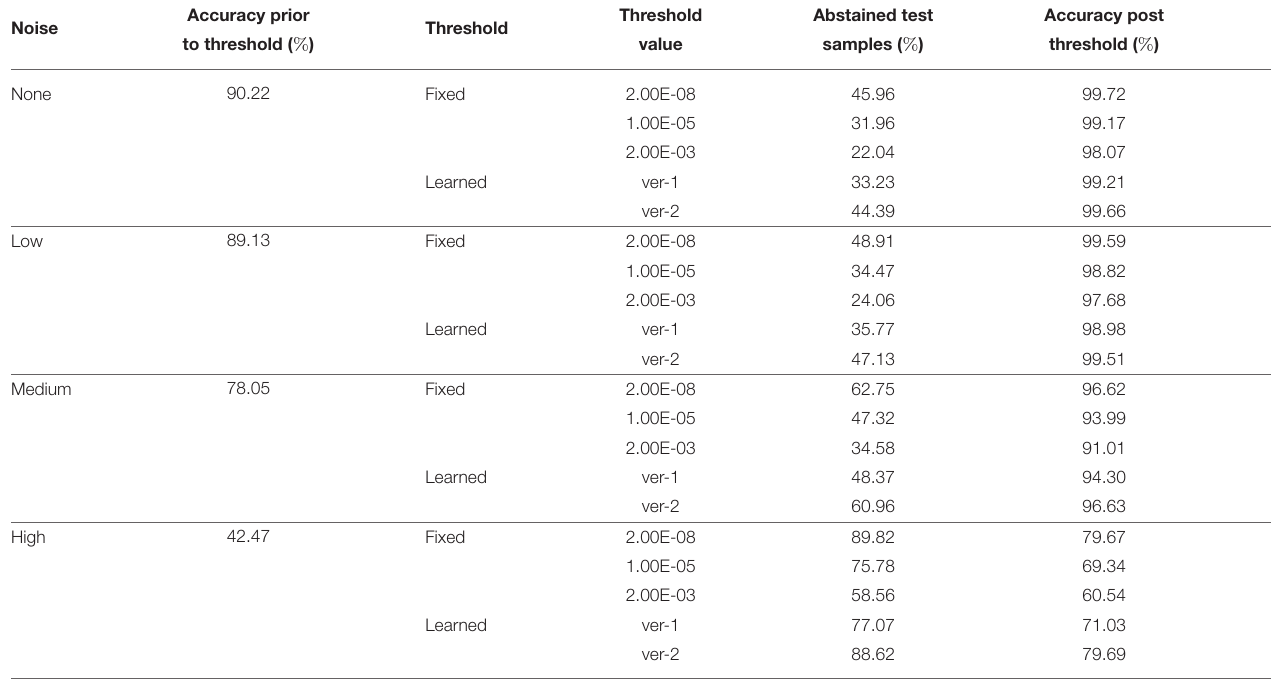
TABLE 7 | Detection of failure in BDNNs—OrganAMNIST dataset tested under various levels of Gaussian noise. Accuracy prior Noise to threshold ( % ) None